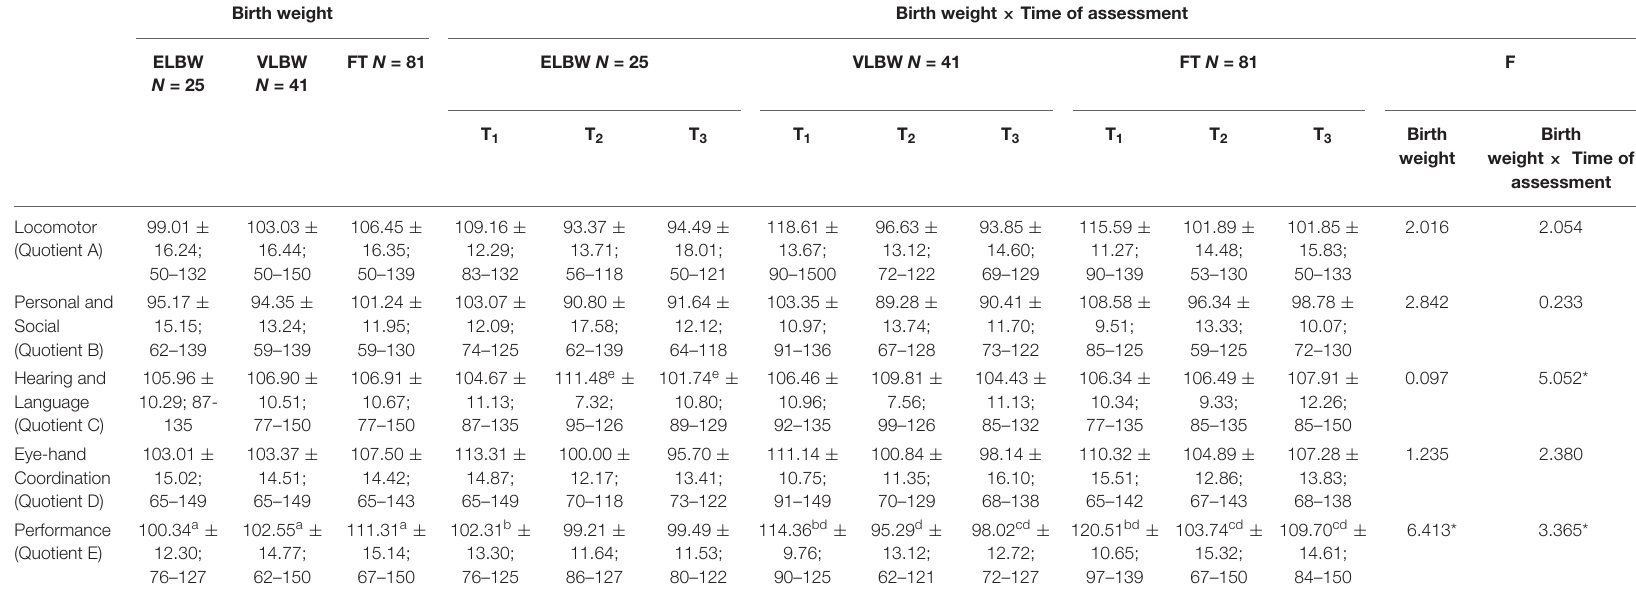
TABLE 2 | Griffiths Mental Development Scales infants’ quotients according to birth weight and time of assessment. Birth weight Birth weight × Time of